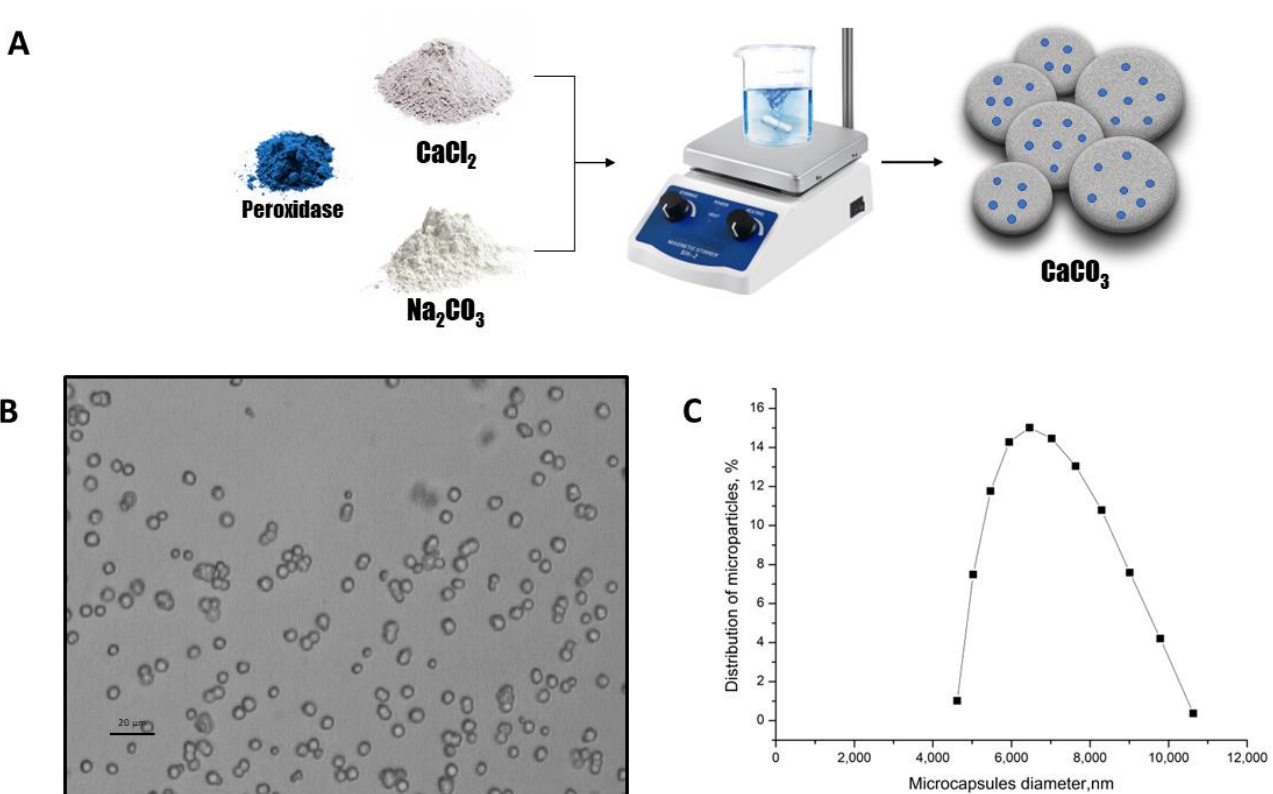
Figure 3. The scheme of the peroxidase-CaCO 3 co-precipitation ( A ). The optical microscopy images of the CaCO 3 microspherulites ( B ). The CaCO 3 microspherulites diameter distribution function ( C ). The optical microscopy images of the CaCO 3 microspherulites (Figure 3B) demon- strate their morphological homogeneity. The average diameter of microspherulites con- tain ing peroxidase was 6.4 μm , with a 25.2% polydispersity index (Figure 3C), and their ζ -potential was +14 ± 1 mV.